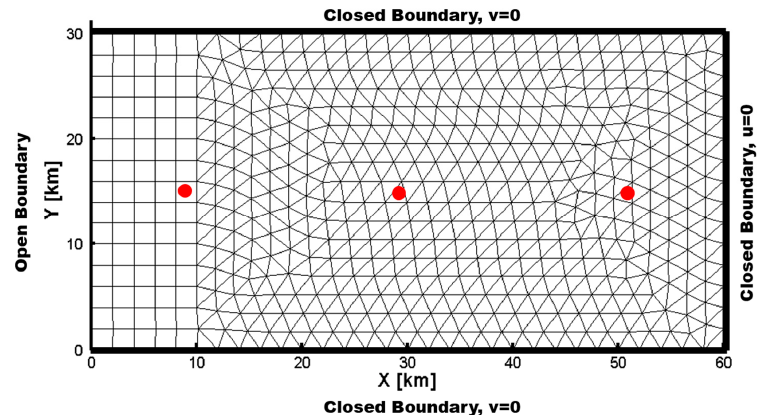
Figure 8. Computation domain and mixed (triangular and quadrilateral) meshes for tidal propagation tests. Three red dots denote the model simulation comparison locations: from the left to the right—station 1, 2, 3.